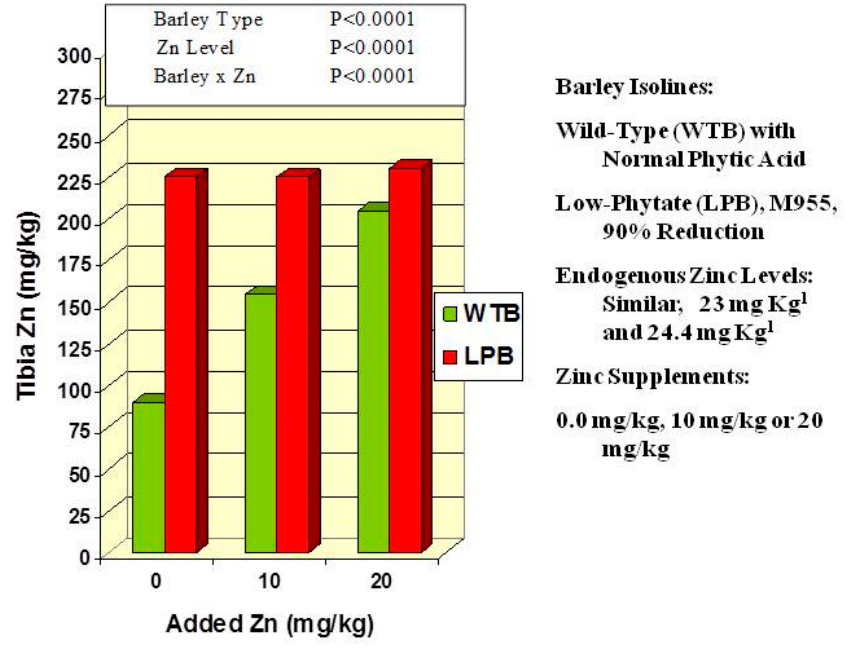
Figure 5. Effect of barley grain phytic acid level and supplemental zinc on chick tibia zinc at 21 days of age. The standard deviation of the mean or “standard error” (“SE”) was 6.08, n = 4. In the case of iron, consider that as part of the Harvest Plus program (https://www.harvestplus.org/), common bean was chosen as one of the main targets for iron